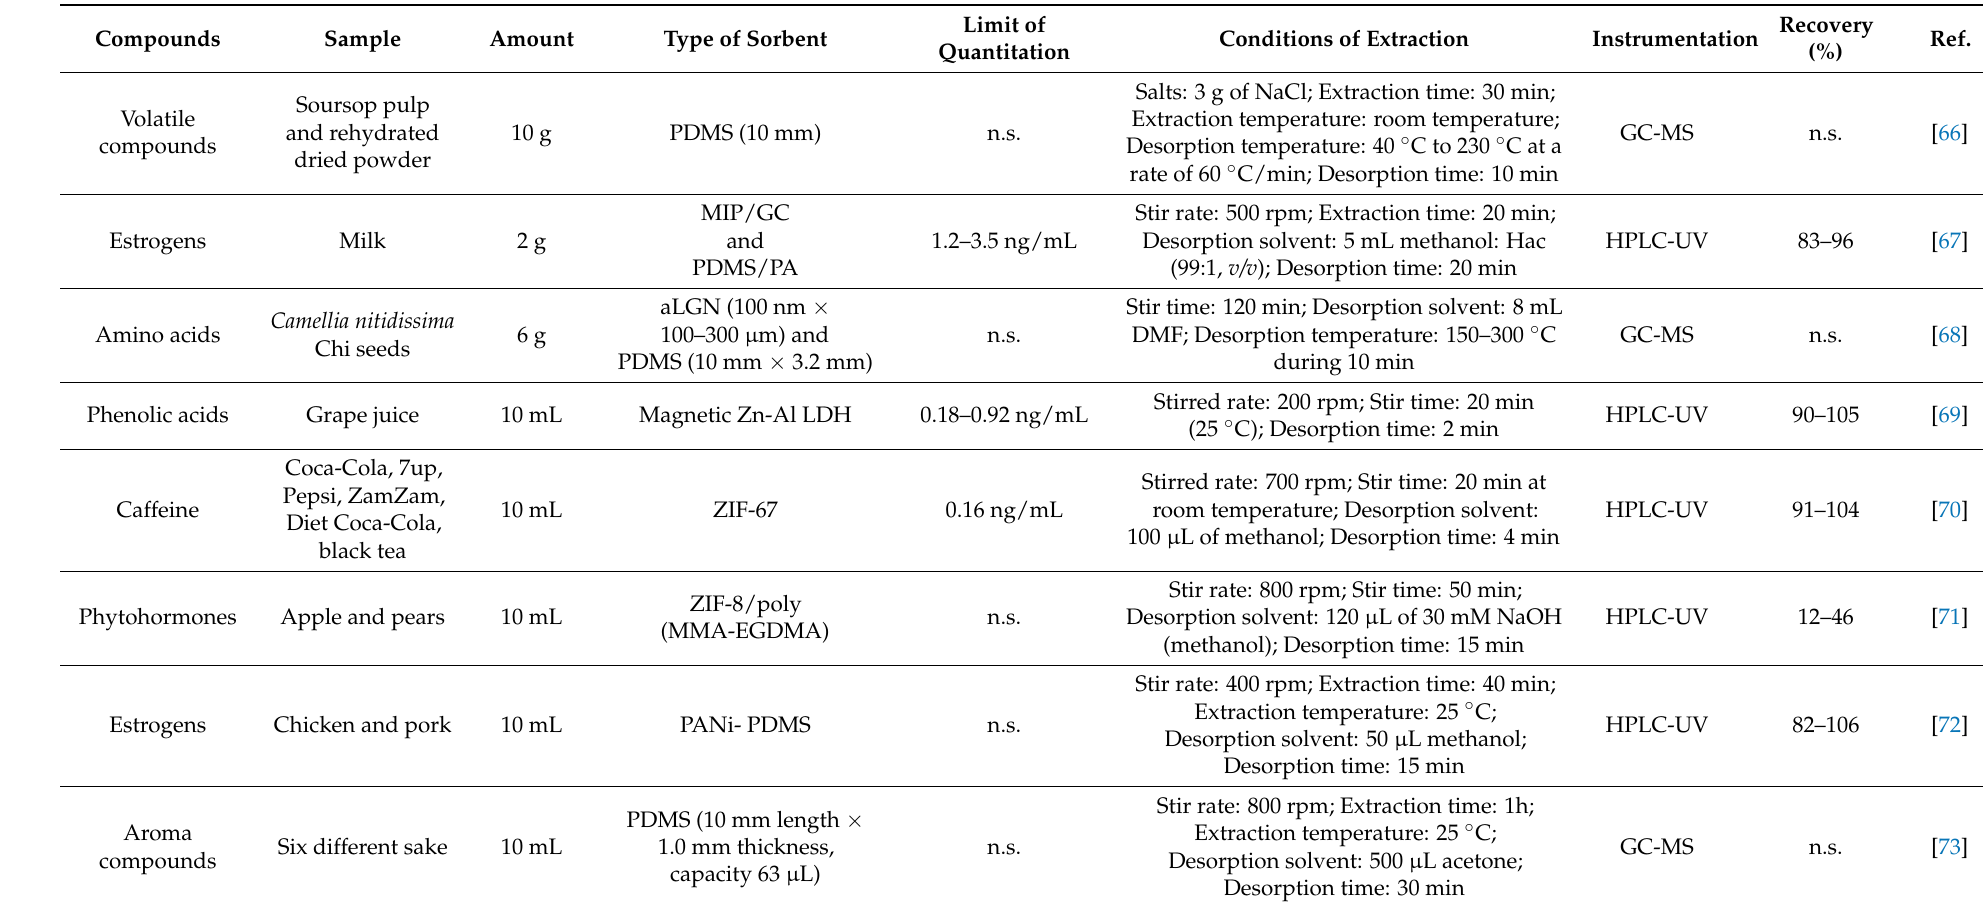
Table 4. Application of SBSE techniques for extraction of several compounds in natural